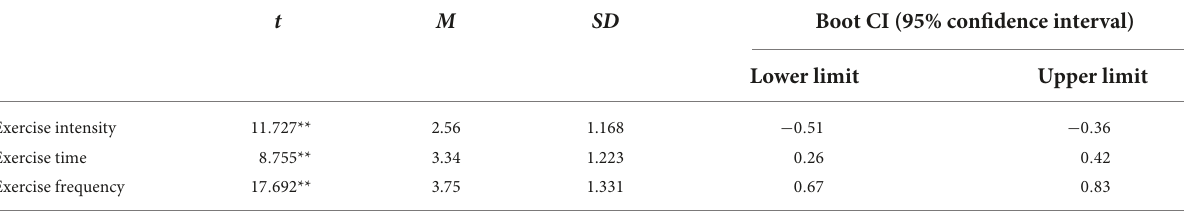
TABLE 1 Single sample statistics and